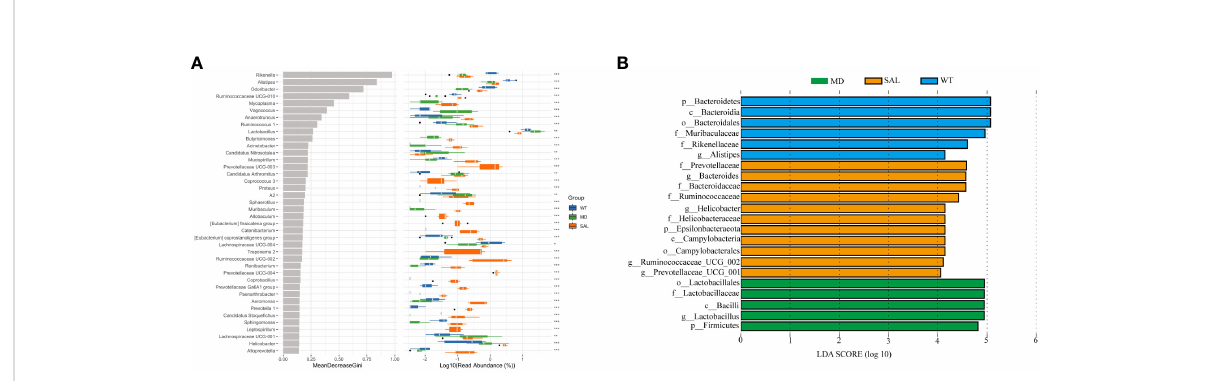
FIGURE 5 Assessment of signi fi cantly different species between groups. (A) , Random forest analysis was combined with a difference test indicating signi fi cant differences in different groups and the importance of classi fi cation between groups. The * on the right represents the signi fi cance of the difference between groups (Kruskal – Wallis rank-sum test) (\*** p < 0.001; \** p < 0.01; \* p < 0.05). (B) , LDA scores plot. The horizontal coordinates were the logarithmic scores of LDA for each class fi cation unit. The vertical coordinates were the class fi cation units with sign fi cant difference between groups. The longer the length, the more sign fi cant the difference